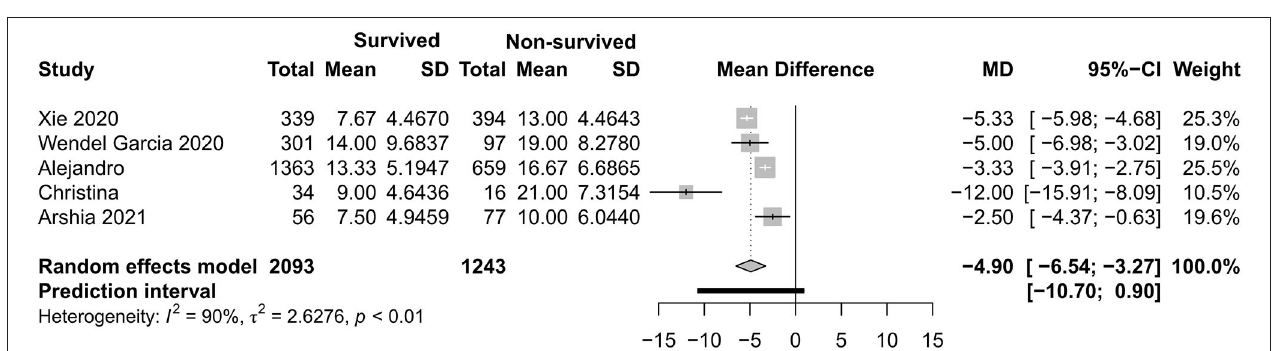
FIGURE 5 | Mean difference of Acute Physiological and Chronic Health Evaluation II score between survived and non-survived